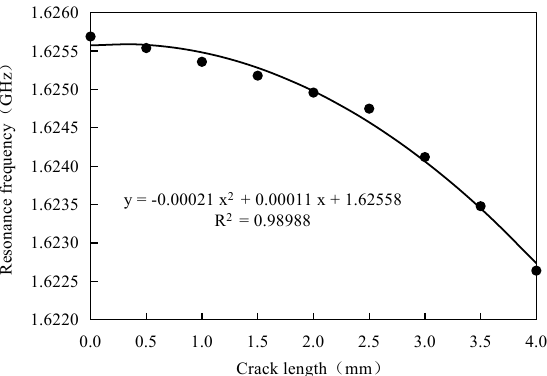
Figure 6. The offset of resonant frequency under small scale